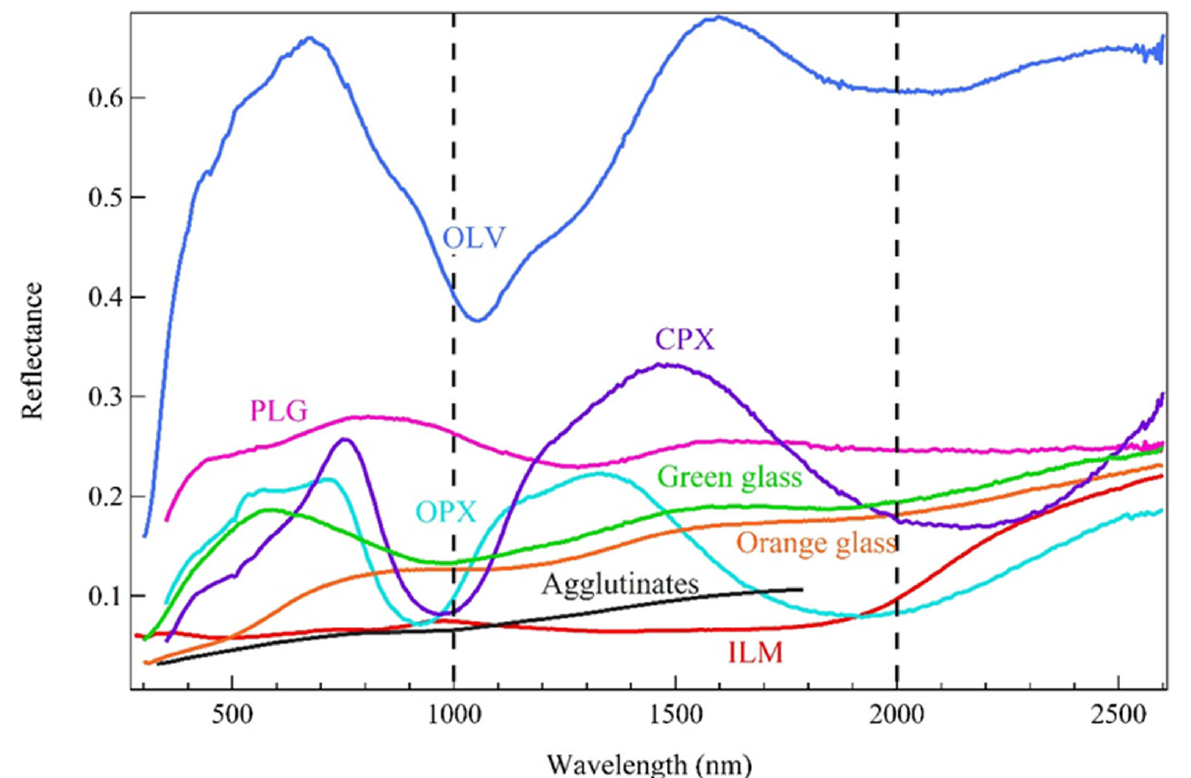
Figure 1. Laboratory reflectance spectra measured at incident zenith angle i = 30°, emission angle e = 0°, and phase angle g = 30° of representative lunar minerals and glasses. Dashed lines at 1000 and 2000 nm indicate the major absorption features of the silicates. The Reflectance Experiment Labora ‐ tory IDs are LR ‐ CMP ‐ 014 for OLV, LS ‐ CMP ‐ 004 for PLG, LS ‐ CMP ‐ 009 for CPX, LS ‐ CMP ‐ 012 for OPX, LR ‐ CMP ‐ 052 for green glass, LR ‐ CMP051 for orange glass, and LR ‐ CMP ‐ 182 for ILM. The agglutinate is the Apollo 15,041 agglutinates spectrum from [25].